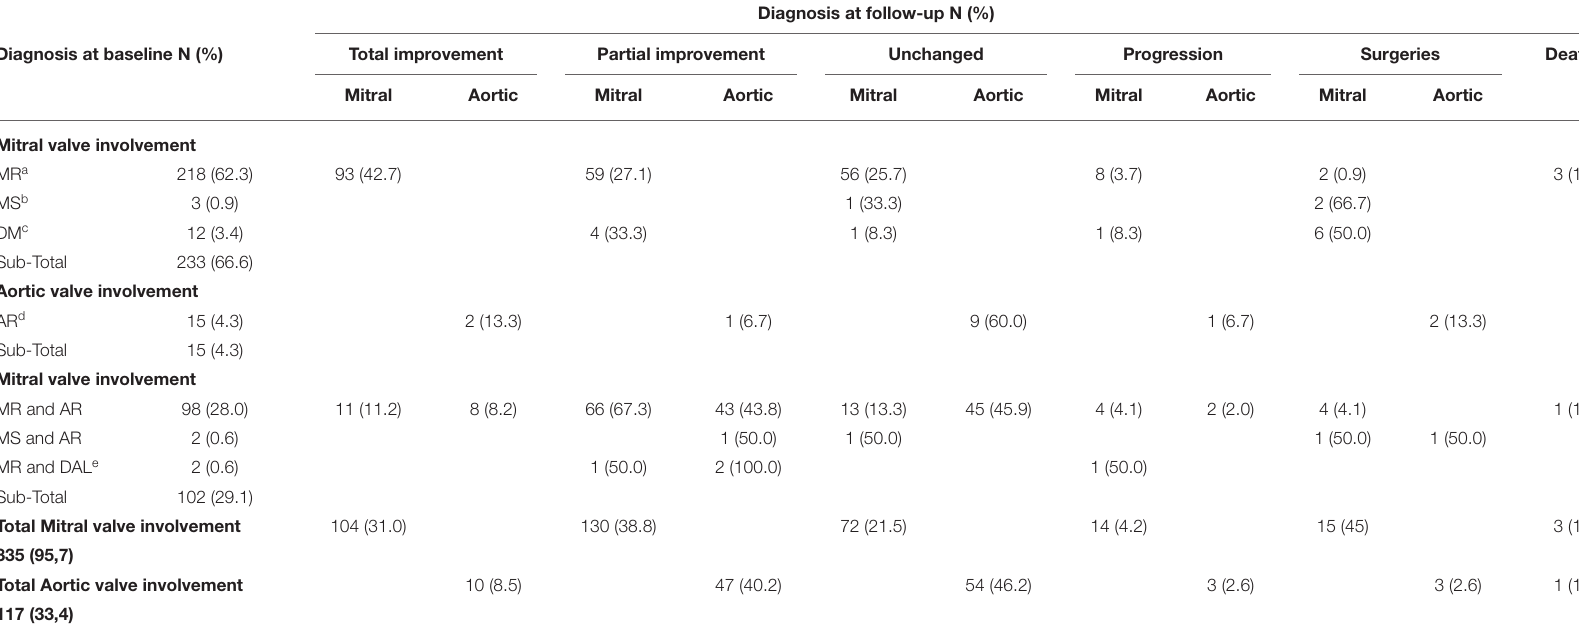
TABLE 2 | Group II: evolution of the cardiac impairment in 350 patients with rheumatic heart disease undergoing prophylactic treatment. Diagnosis at follow-up N (%) Diagnosis at baseline N (%) Total improvement Partial improvement Unchanged Progression